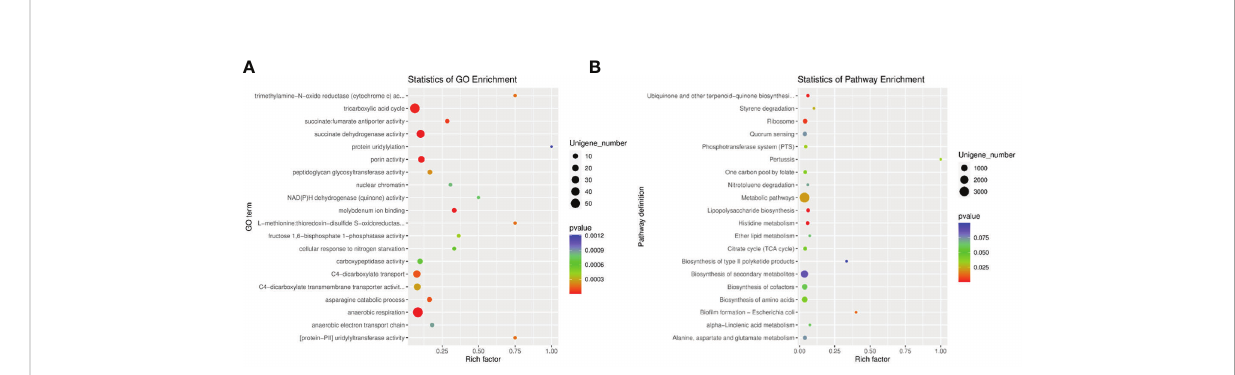
FIGURE 6 The enrichment analysis in RA and control group. (A) GO enrichment analysis of differentially expressed unigenes between RA and control groups. (B) Pathway classi fi cation based on KEGG enrichment analysis of differentially expressed unigenes between RA and control groups. Rich factor, is the ratio of the number of differentially expressed genes (DEGs) to the number of total genes in this pathway.